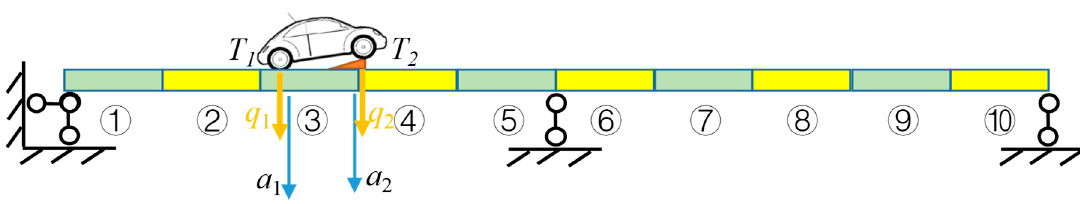
Figure 22. A two-span continuous bridge with 4-DOF vehicle model ( T 2 bump)).